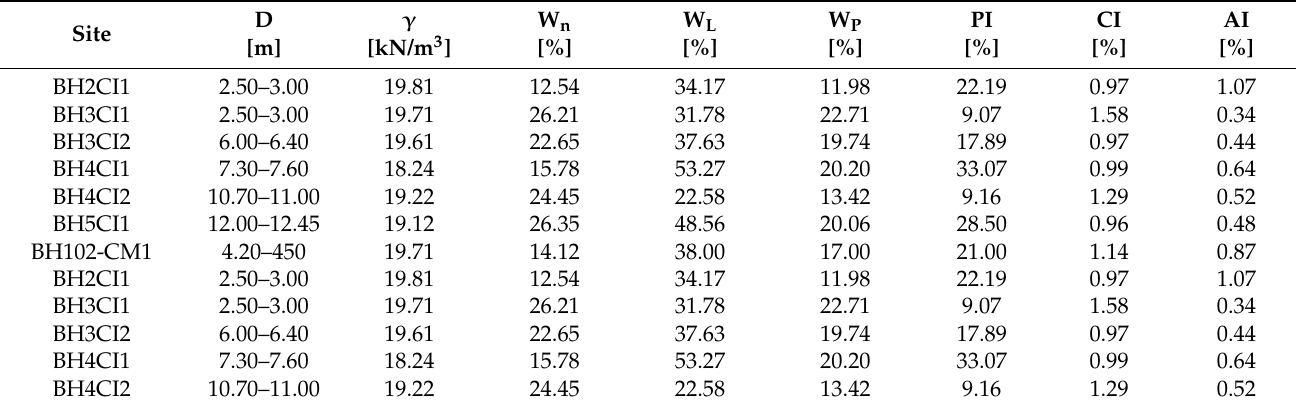
Table 2. Mechanical characteristics for Caronia area.